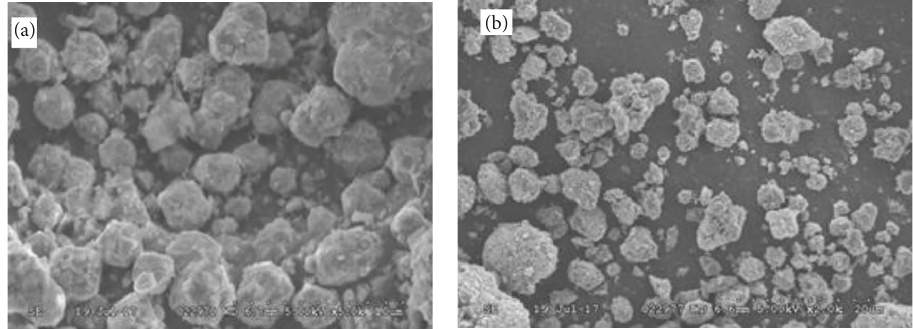
Figure 3: The SEM images of (a) 13X and (b) Fe